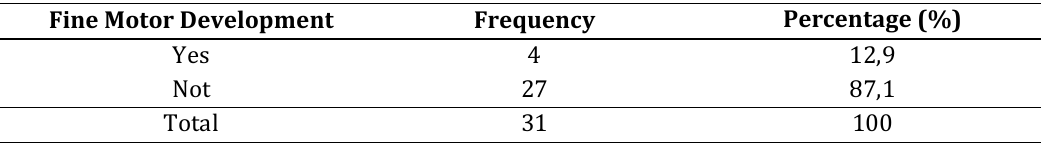
Distribution of Fine Motor Development Before Stimulation of Educational Game Tools in Srikandi Kindergarten Lhokseumawe (n=31)